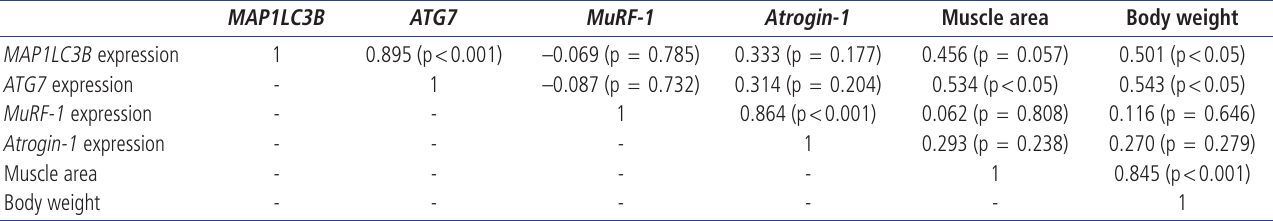
Table 1. Correlations among M. longissimus expression of genes associated with autophagy and the ubiquitin-proteasome system, ultrasonic M. longissimus area, and body